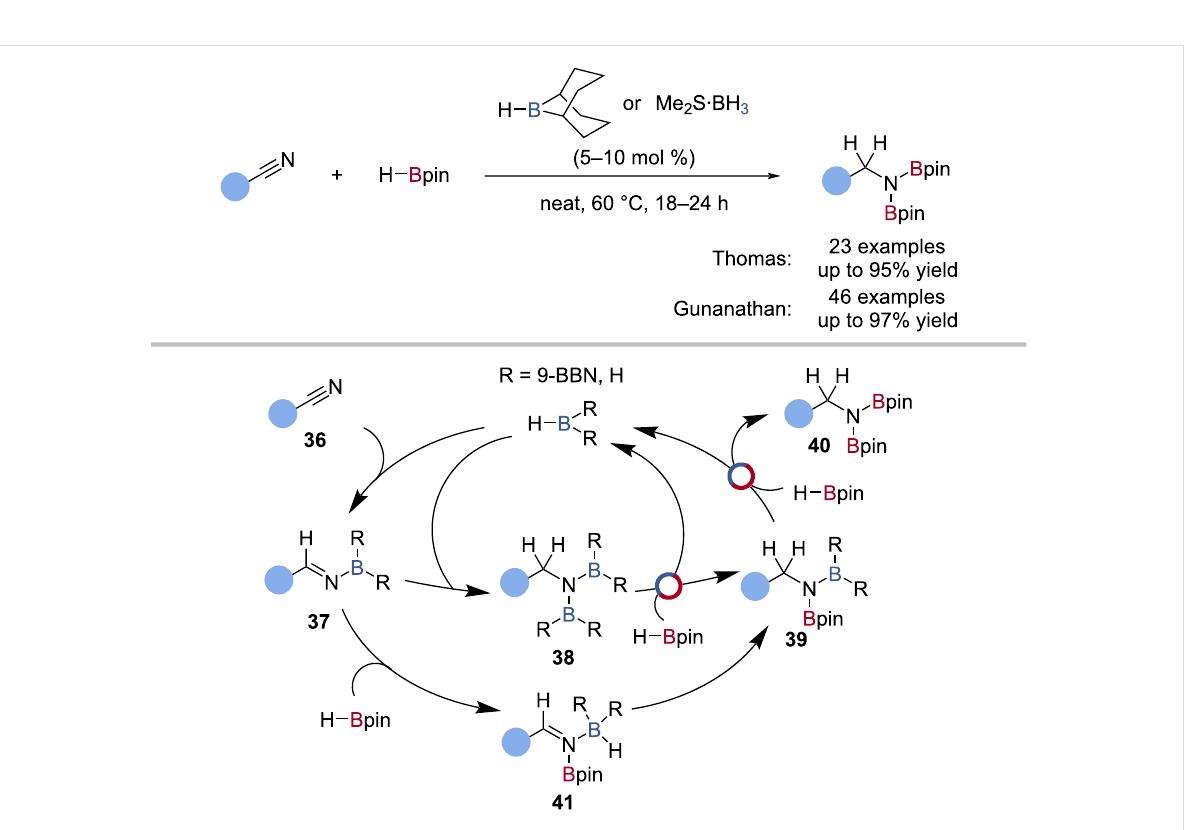
Scheme 9: Borane-catalysed hydroboration of nitriles and the proposed